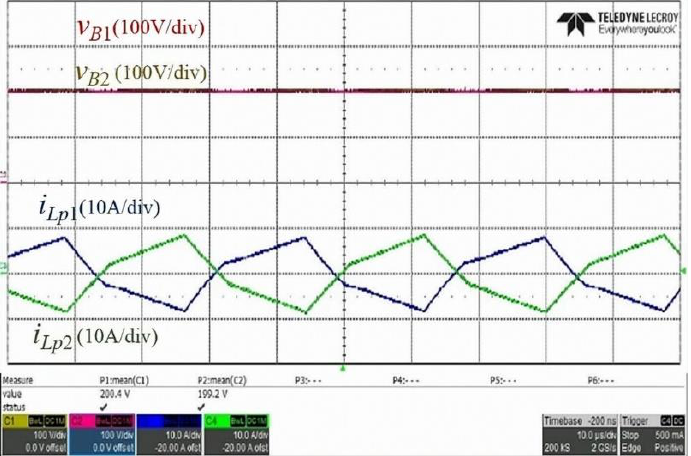
Figure 15. Experimental waveforms of the voltage across the series inductors and the current through the series inductors.